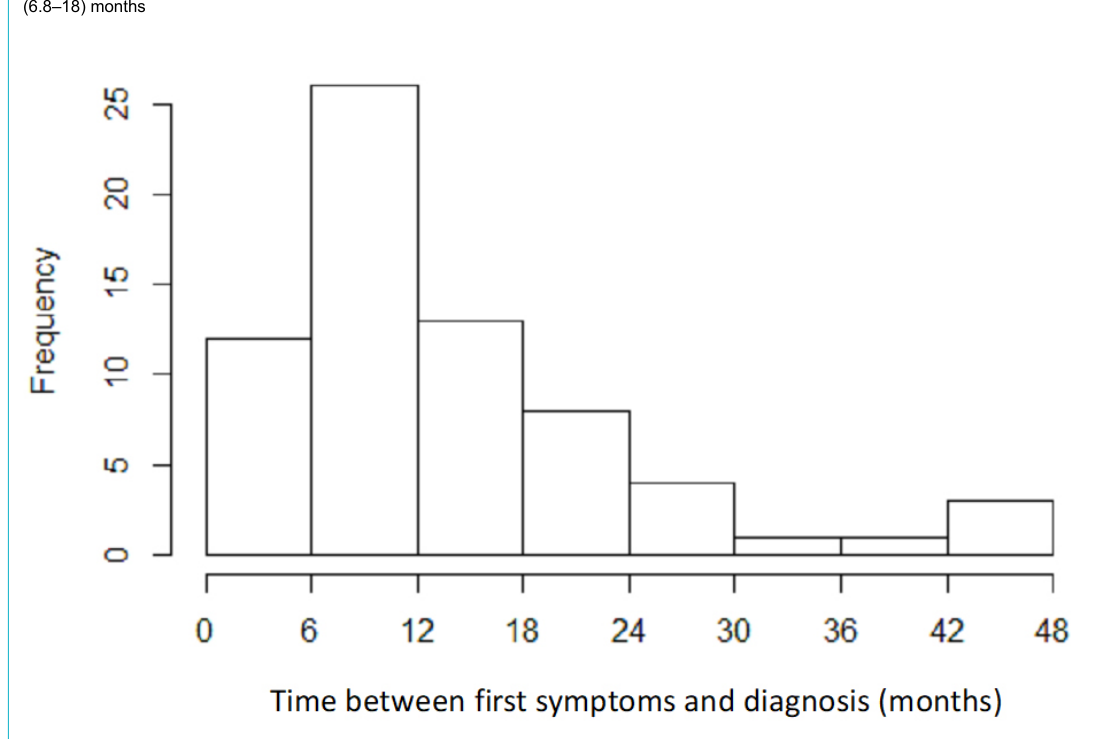
Figure 2: Distribution of delay between first symptoms according to medical history and diagnosis; n = 68 subjects. Median (Q1–Q3) 11.1 (6.8–18)